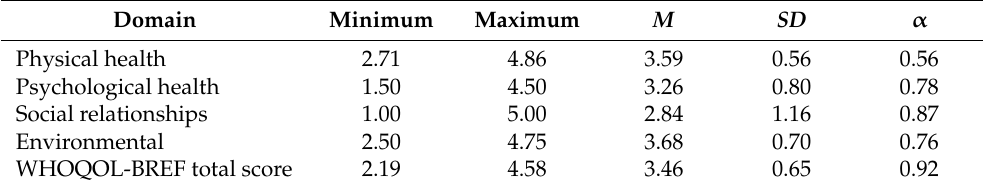
Table 3. Descriptive statistics and Cronbach’s alphas of the world health organization quality of life assessment (WHOQOL-BREF) domains and total